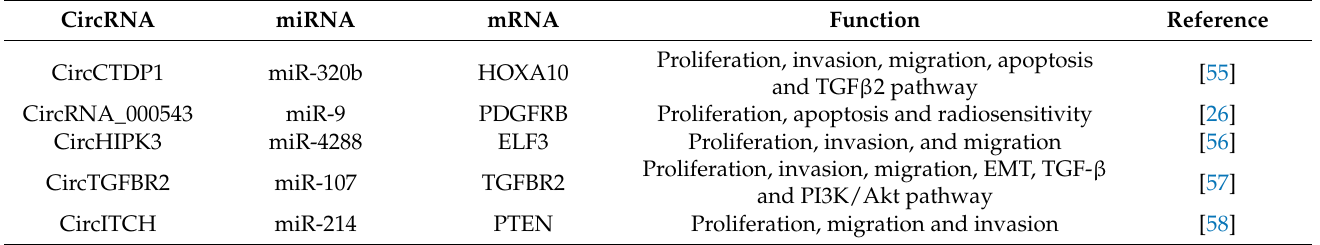
Table 2. CeRNA networks of circRNA-miRNA-mRNA involved in NPC proliferation and